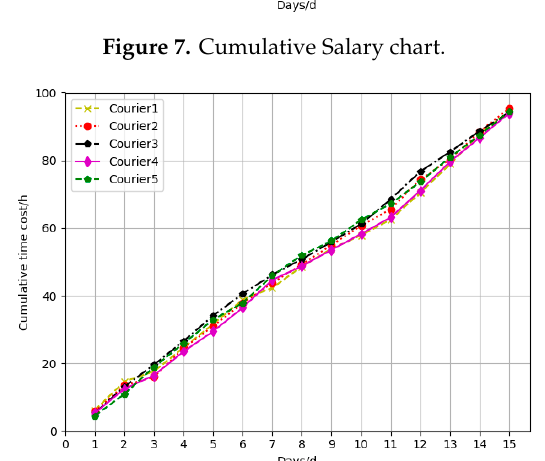
Electronics 2019 , 8 , x FOR PEER REVIEW Figure 8. Cumulative time cost diagram. Figure 8. Cumulative time cost diagram. Figure 8. Cumulative time cost diagram.